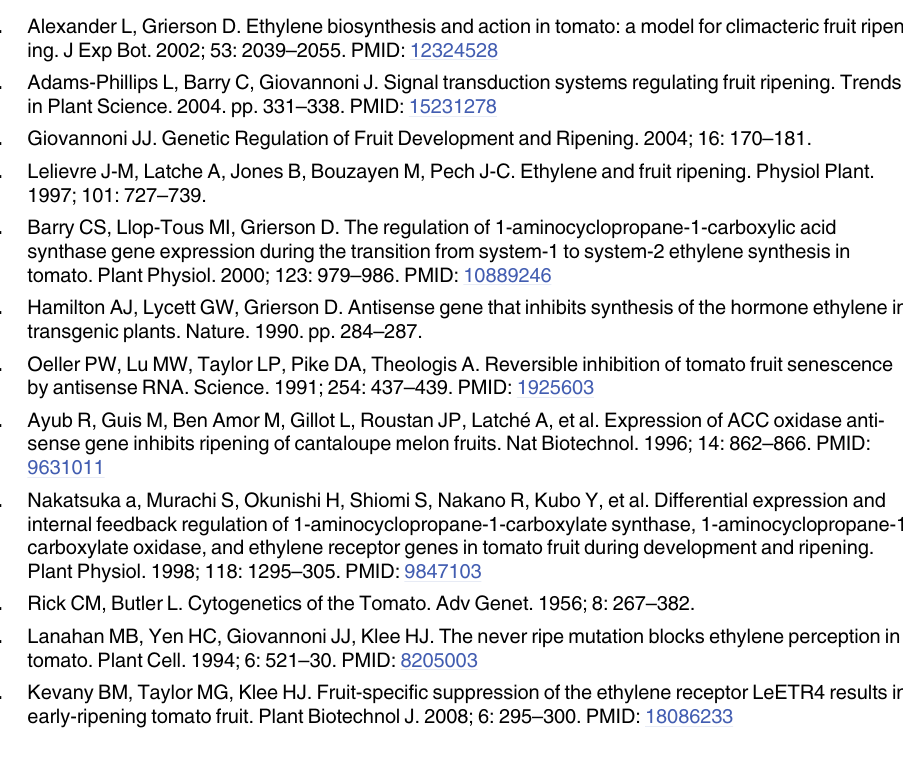
S1 Table. List of primers used in the expression studies. (PDF) S1 Fig. Auxin related phenotypes displayed by SlARF2A/B-RNAi lines. (A) SlARF2A/ B-RNAi lines showing the development of triple cotyledons. (B) SlARF2A/B lines showing root branching phenotypes. (PDF) S2 Fig. Expression of SlARF in SlARF2AB-RNAi fruits assessed by Quantitative RT-PCR. Total RNA was extracted from WT and mutant fruits at the breaker stage. The relative mRNA levels of each SlARF gene in WT were standardized to 1.0, referring to the SlActin gene as inter- nal control. Error bar means ±SD of three biological replicates. Stars indicate statistical signifi- cance using Student ’ s t-test: (cid:1) p-value < 0.05, AB1 refers to SlARF2AB-RNAi line 311.